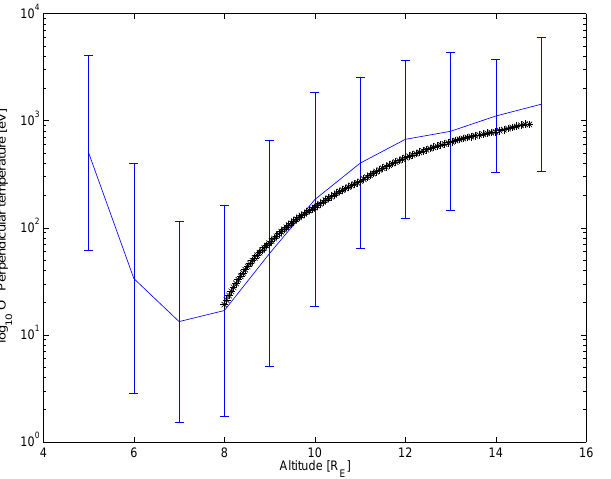
Fig. 7. Profile of the total magnetic field versus altitude. The blue error bars show the standard deviation for the logarithmic values. The black dashed line is the dipole model.